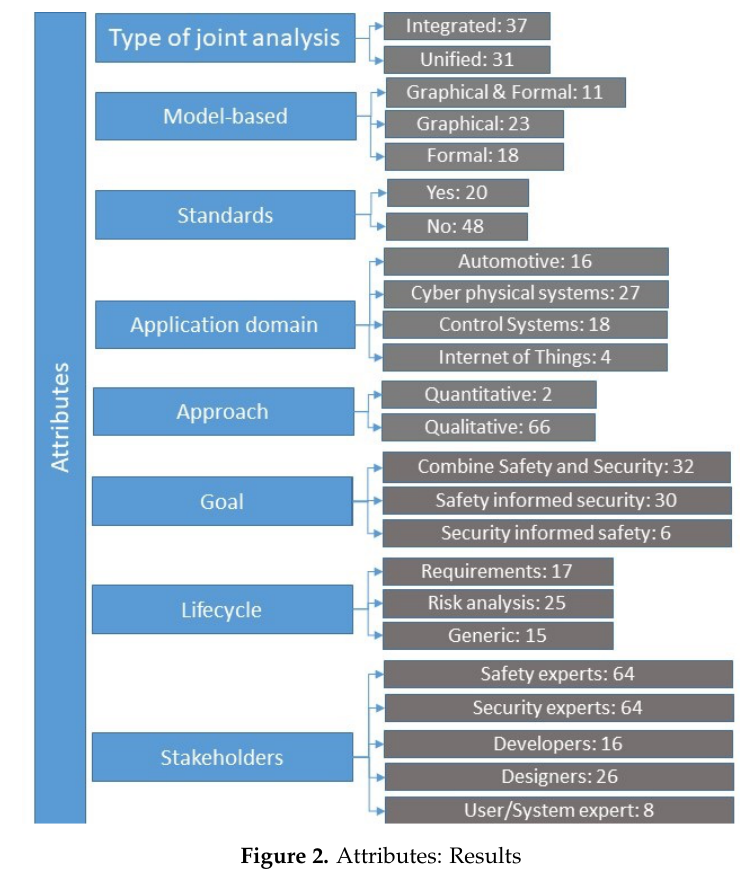
Figure 2. Attributes: Results